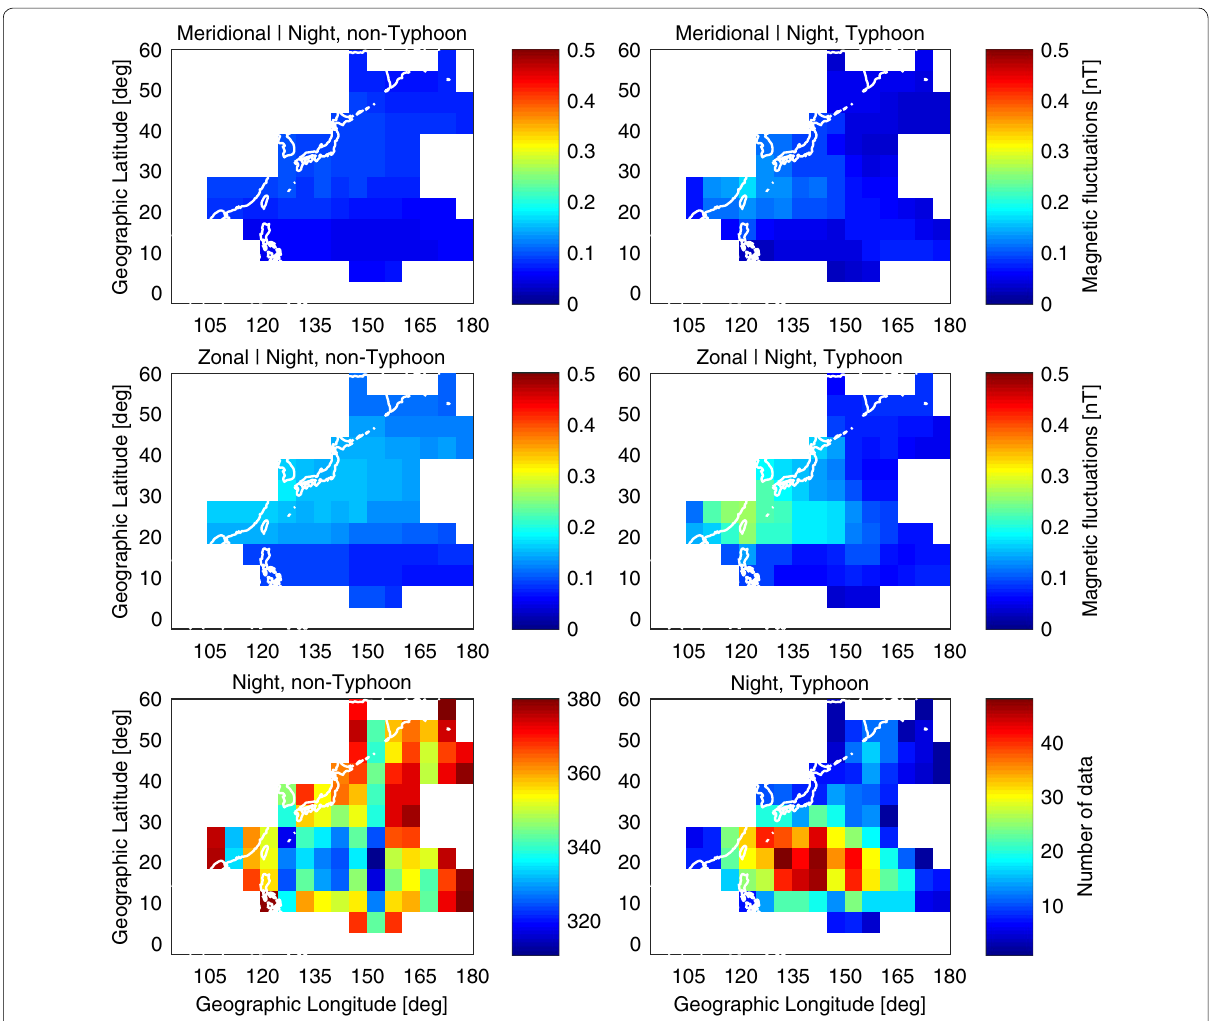
Fig. 13 Comparison of average MR amplitudes between typhoon and non-typhoon cases. The left and right panels show non-typhoon and typhoon cases on the night side sector (21–3 LT), respectively. Average amplitudes of the meridional ( top ) and zonal ( middle ) components, and number of data ( bottom ) in each mesh grid are shown